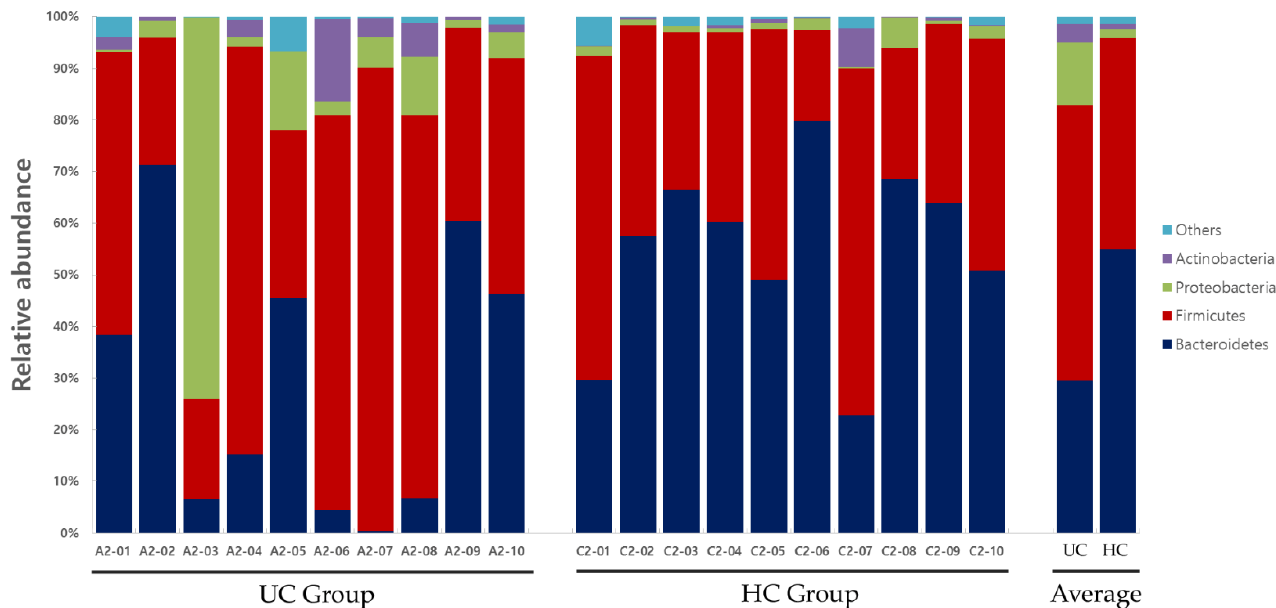
Figure 8. Gut microbiota composition at the phylum level in UC and HC groups. UC, ulcerative